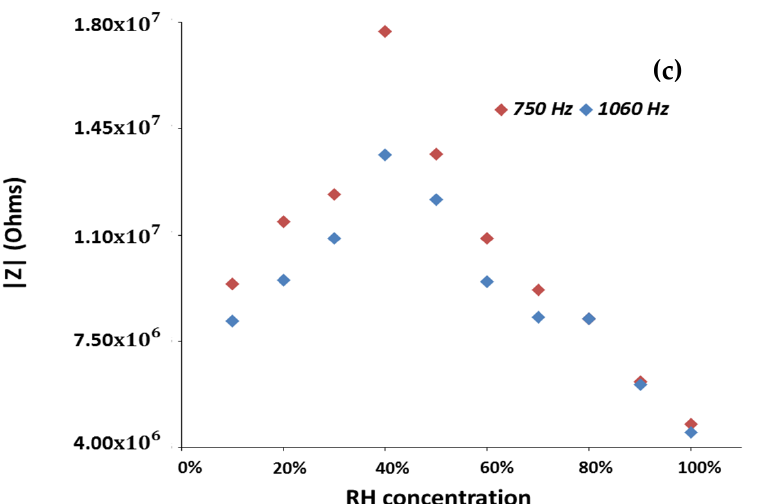
Figure 7. ( a ) Impedance modulus plots of the 𝑀𝑂𝐻𝑁 obtained samples as a function of RH, at two different operating frequencies, for the ( a ) TW, ( b ) 𝑇𝑊 − 𝑍𝑛2 , and ( c ) 𝑇𝑊 − 𝑍𝑛4 .